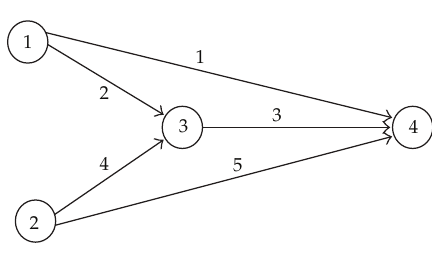
Figure 3: The network for Example